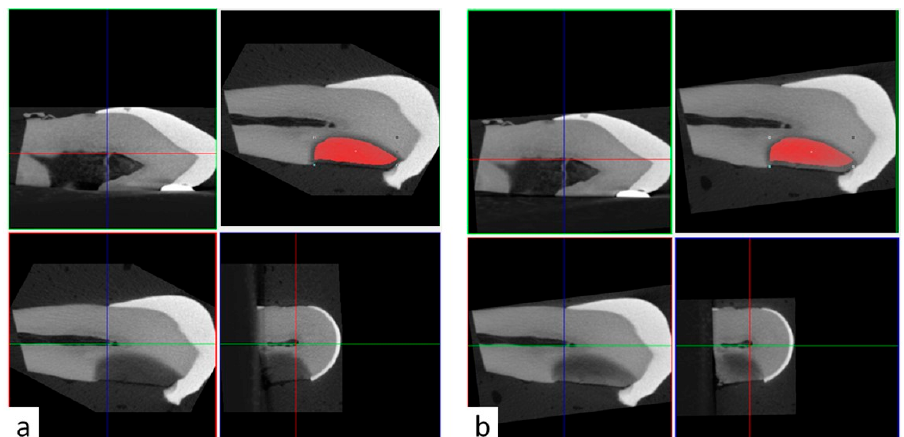
Figure 1. Three dimensional coregistration of reconstructed 3D images using DataViewer software. ( a ) Preoperative micro-CT images showing the region of interest (red outline) adapted to the carious lesion. ( b ) Coregistered 3D micro-CT images after application of a radiopaque material (e.g., potassium iodine) with the same region of interest transferred from preoperative to post-operative images.